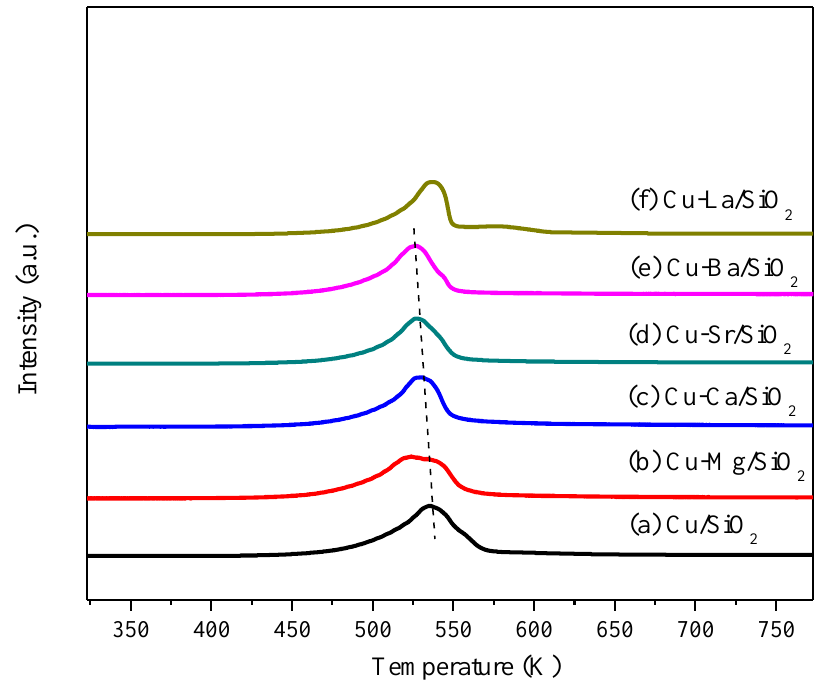
Figure 2. H 2 -TPR profiles of the calcined catalysts: ( a ) Cu/SiO 2 ; ( b ) Cu-Mg/SiO 2 ; ( c ) Cu-Ca/SiO 2 ; ( d ) Cu-Sr/SiO 2 ; ( e ) Cu-Ba/SiO 2 ; ( f ) Cu-La/SiO 2.